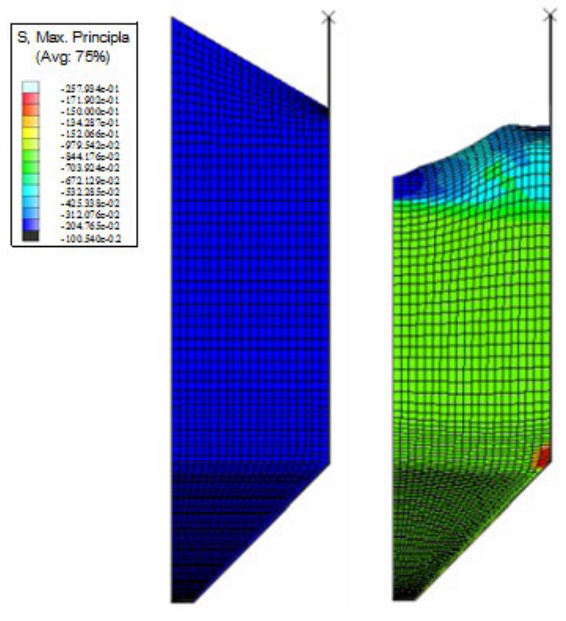
Figure 17 : Time-adaptive grid distortion for the case without the use of insert (Abaqus)